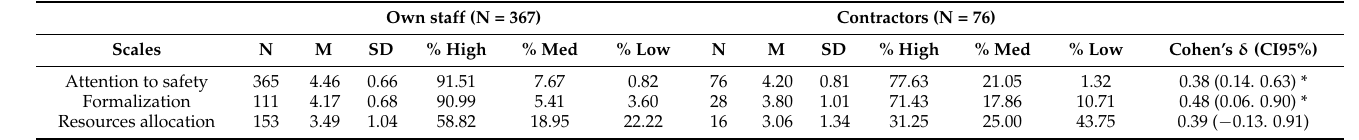
Table 11. Descriptive statistics of the BARS by contractual relationship.